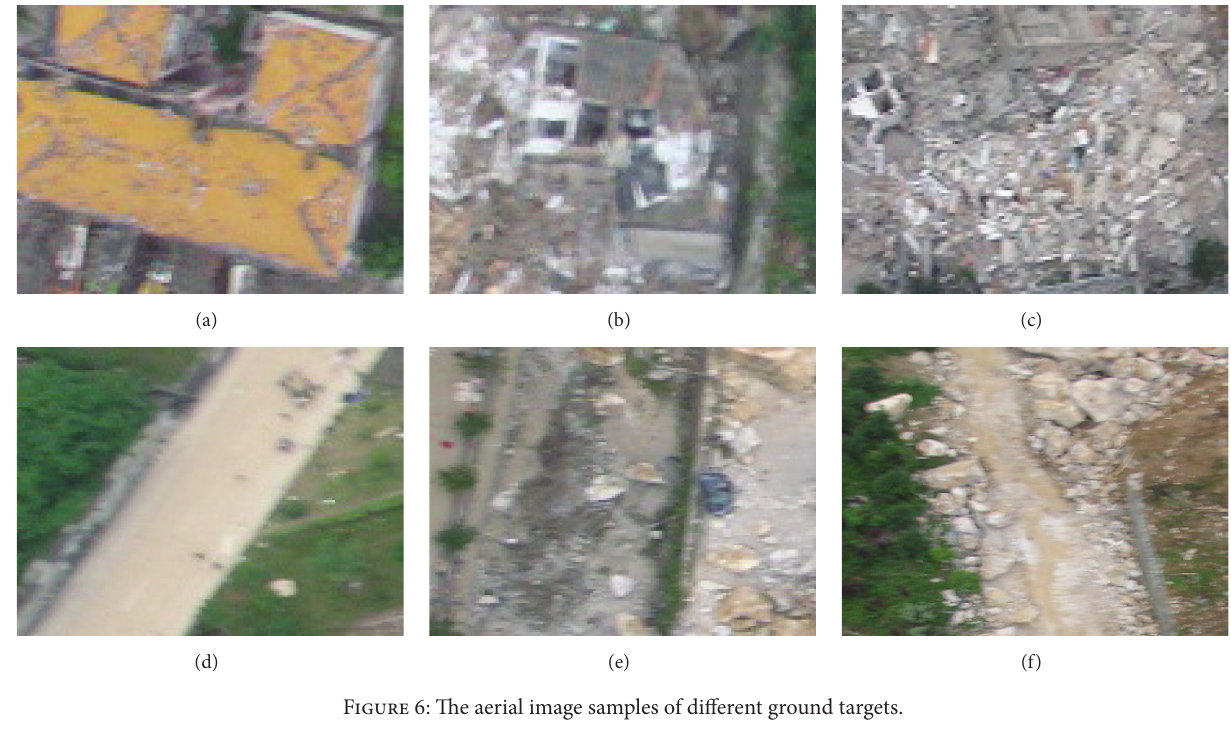
Figure 6: The aerial image samples of different ground targets.